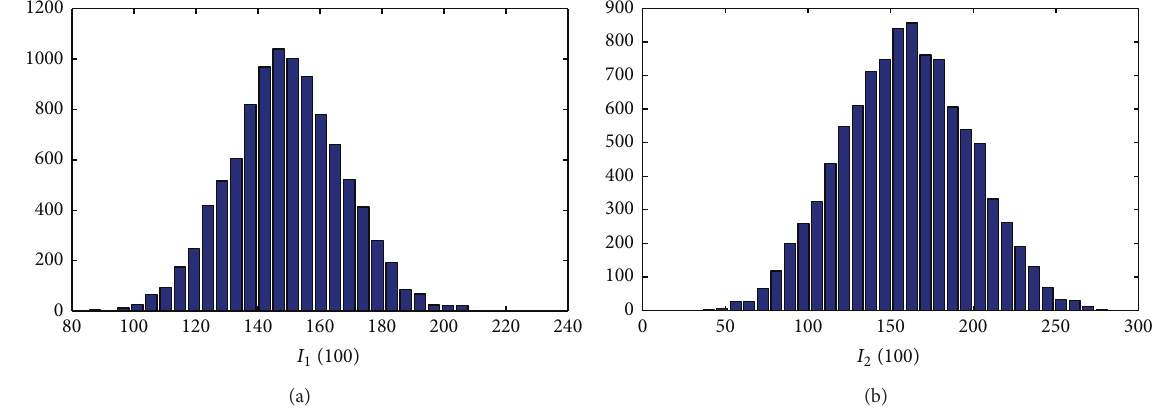
Figure 4: Frequency histograms of paths 𝐼 1 (𝑡) , 𝐼 2 (𝑡) for the system (31) based on 10000 stochastic sumulations for each population at time 𝑡 = 100 , using the EM method with step size 0.001, with initial values 𝐼